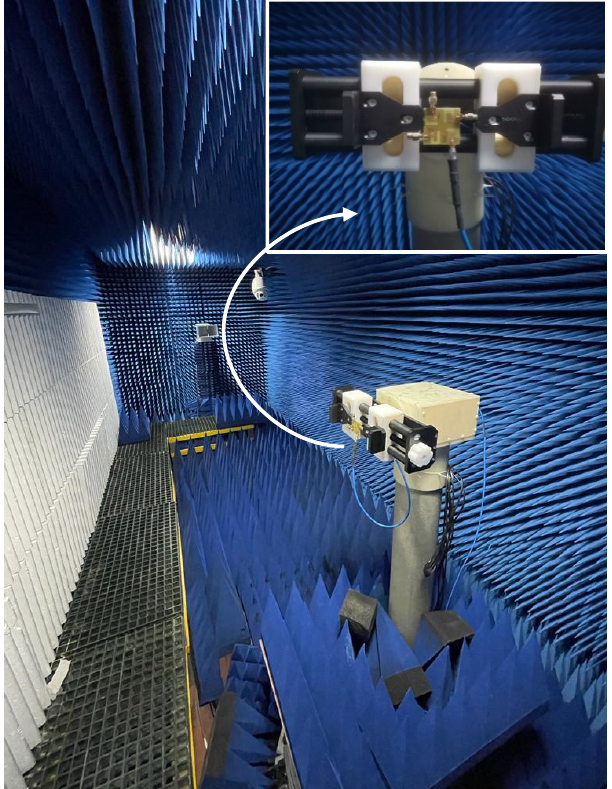
Figure 6. Fabricated prototype of the proposed antenna design: ( A ) top view and ( B ) bottom view.